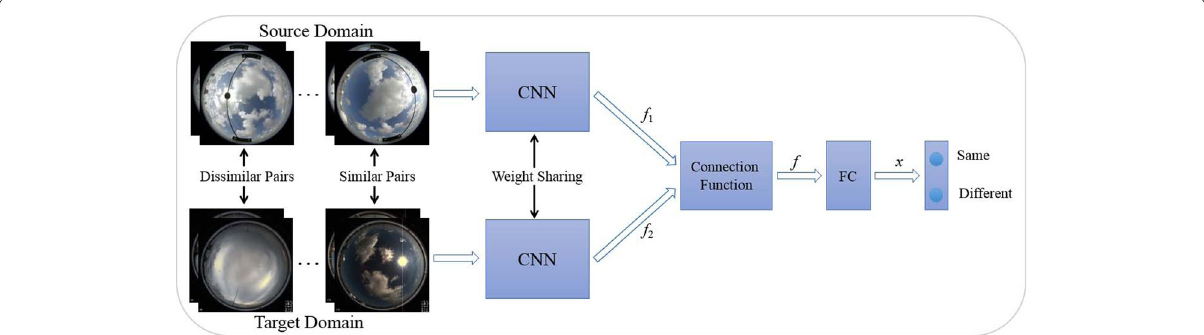
used in the two CNN models are the same. The weight sharing strategy is an important principle in the siamese network because it helps to reduce the total number of trainable parameters. Furthermore, weight sharing leads to more efficient training and more effective model espe- cially when some similar local structures appear in the input feature